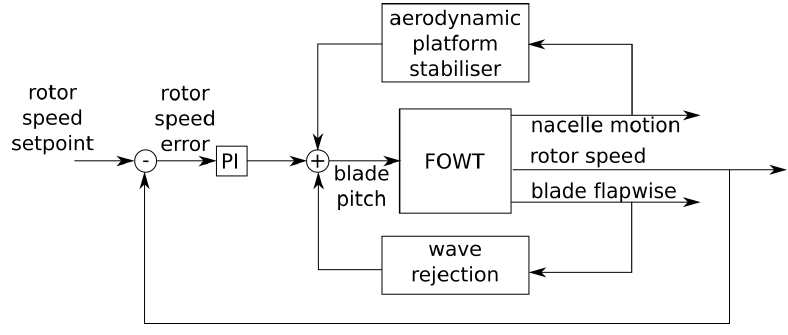
Figure 3. Conventional PI, Aerodynamic Platform Stabiliser and Wave Rejection feedback control loops.